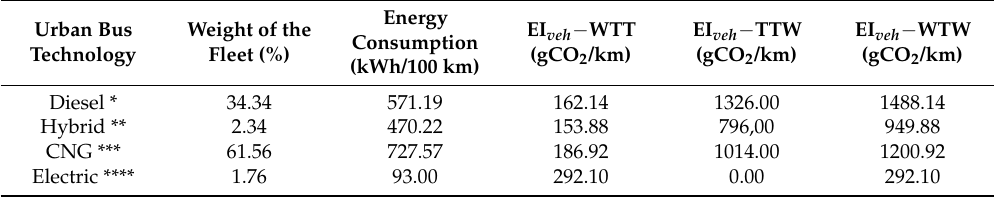
Table 16. Comparison of the CO 2 emissions from different buses in the